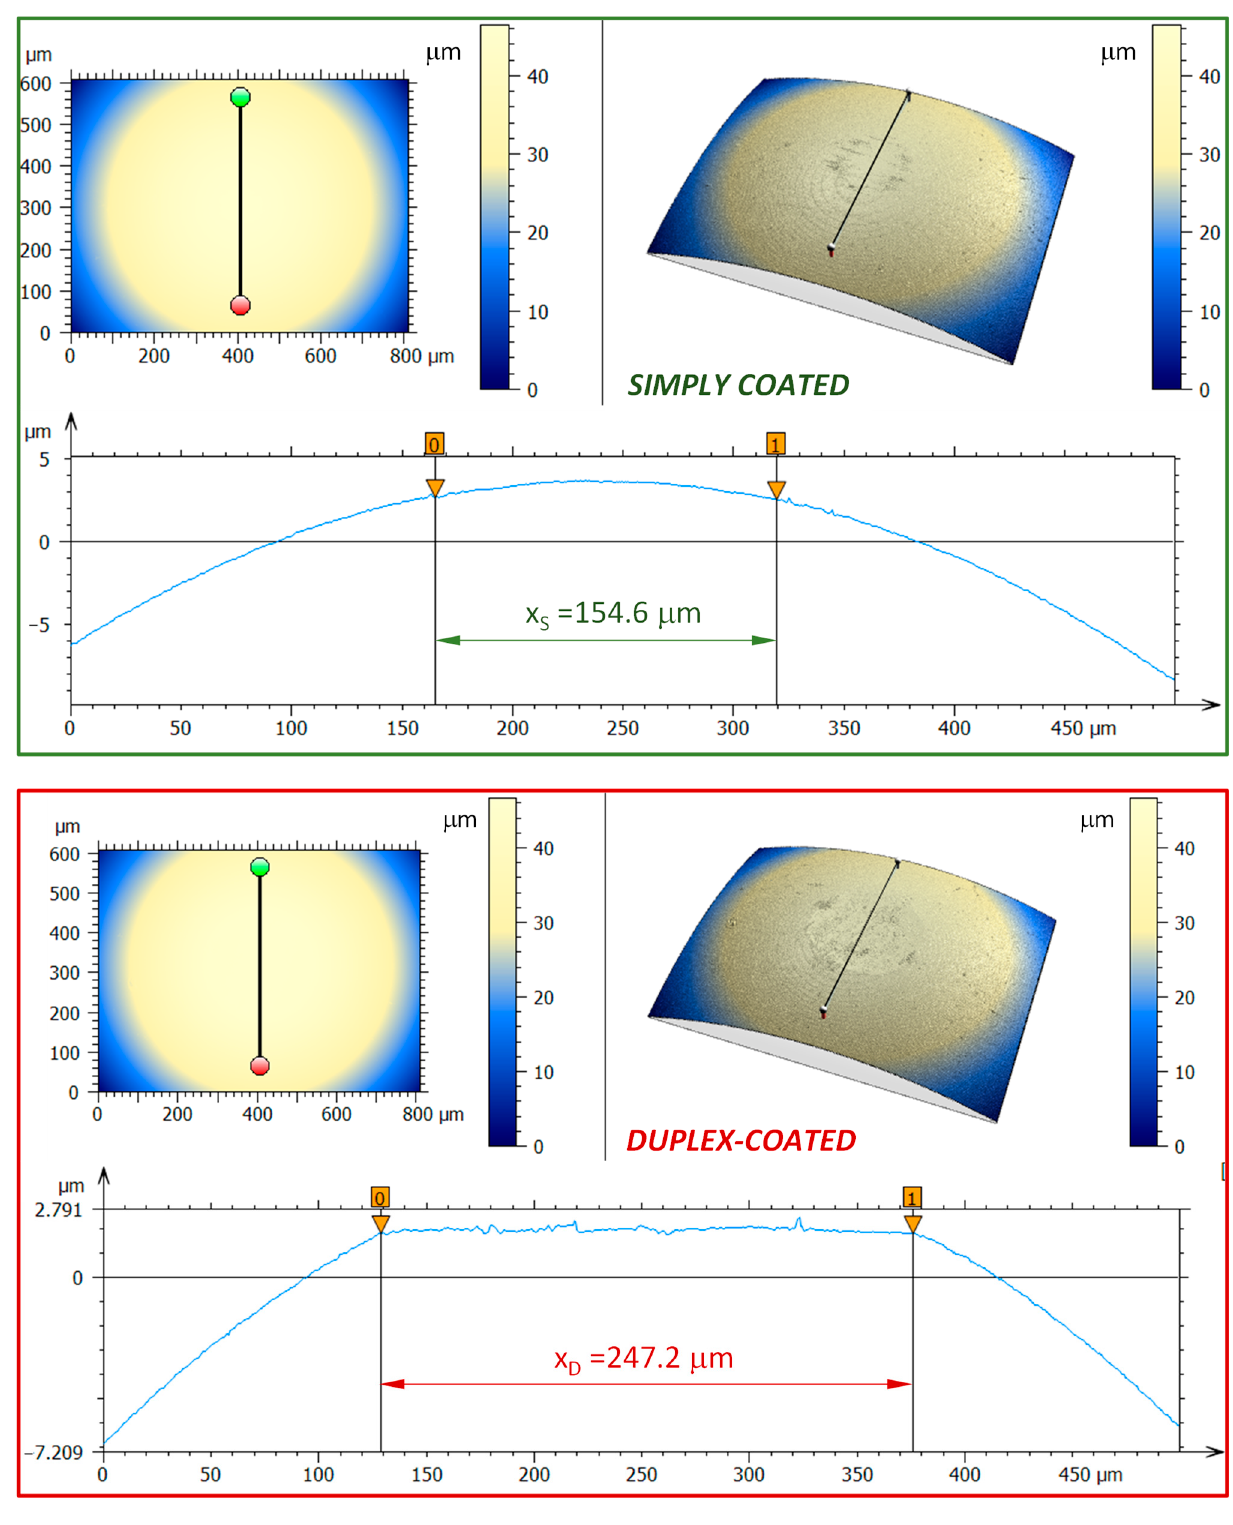
Figure 8. 2D and 3D profile of the wear track of the ball counterpart of the simple-coated (up) and the duplex-coated (down) discs. Consider the different scales along the vertical axes of the profile curves. Similarly, an unexpected decrease in the hardness below the worn surface was re- ported by Mussa et al. during the reciprocating wear test of the case-hardened